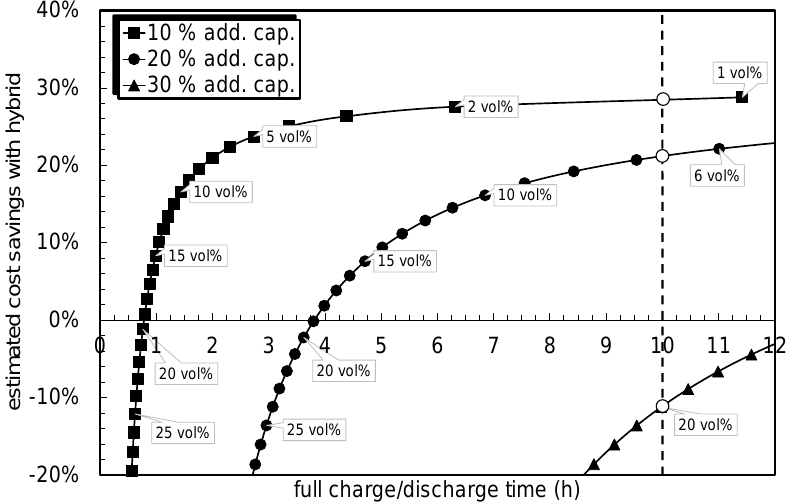
Figure 9. Cost savings comparing hybrid with Ruths, i.e., savings are the ratio of Ruths steam storage costs to hybrid costs. Al content in PCM is given in